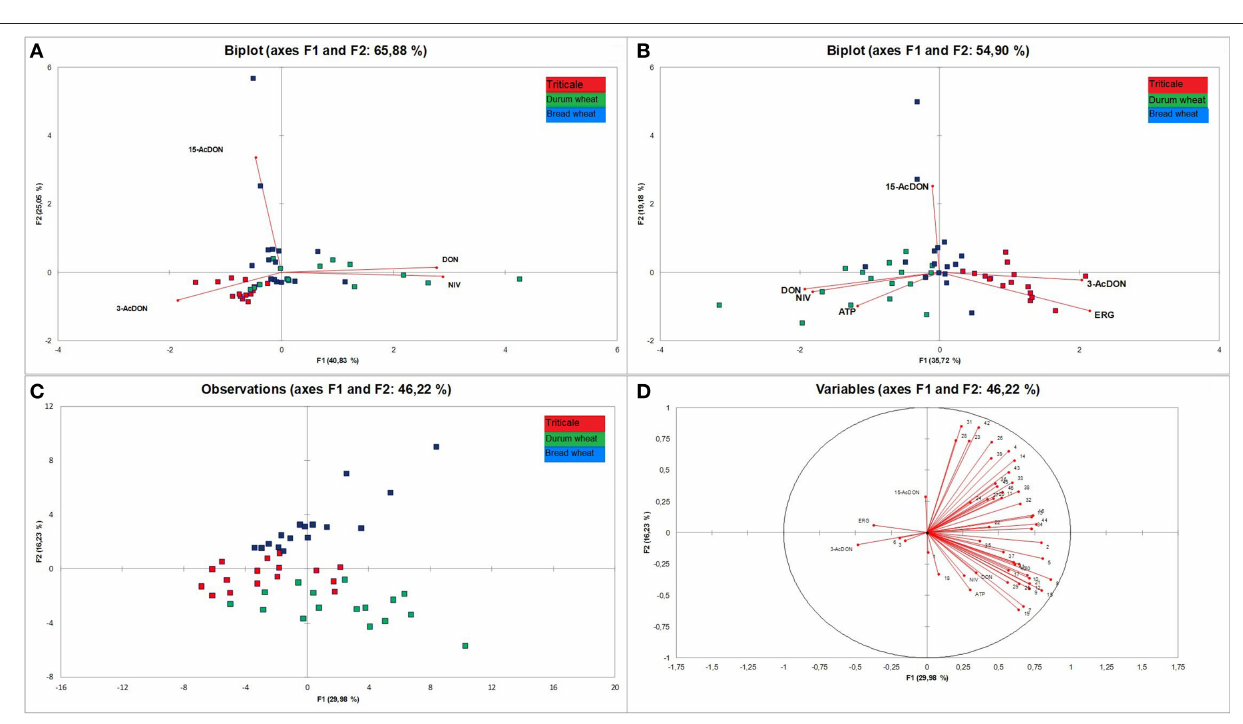
FIGURE 6 | Principal component analysis (PCA) biplots for trichothecenes of group B (A), trichothecenes, and fungal biomass indicators (ERG and ATP) (B) analyzed in 48 samples of cereal grain (triticale—red, durum wheat—green, and bread wheat—blue) and plot representing grain samples distribution (C) and correlation circle (D) of trichothecenes. ERG, ATP, and VOCs (numbers correspond to compound names as in Table 3